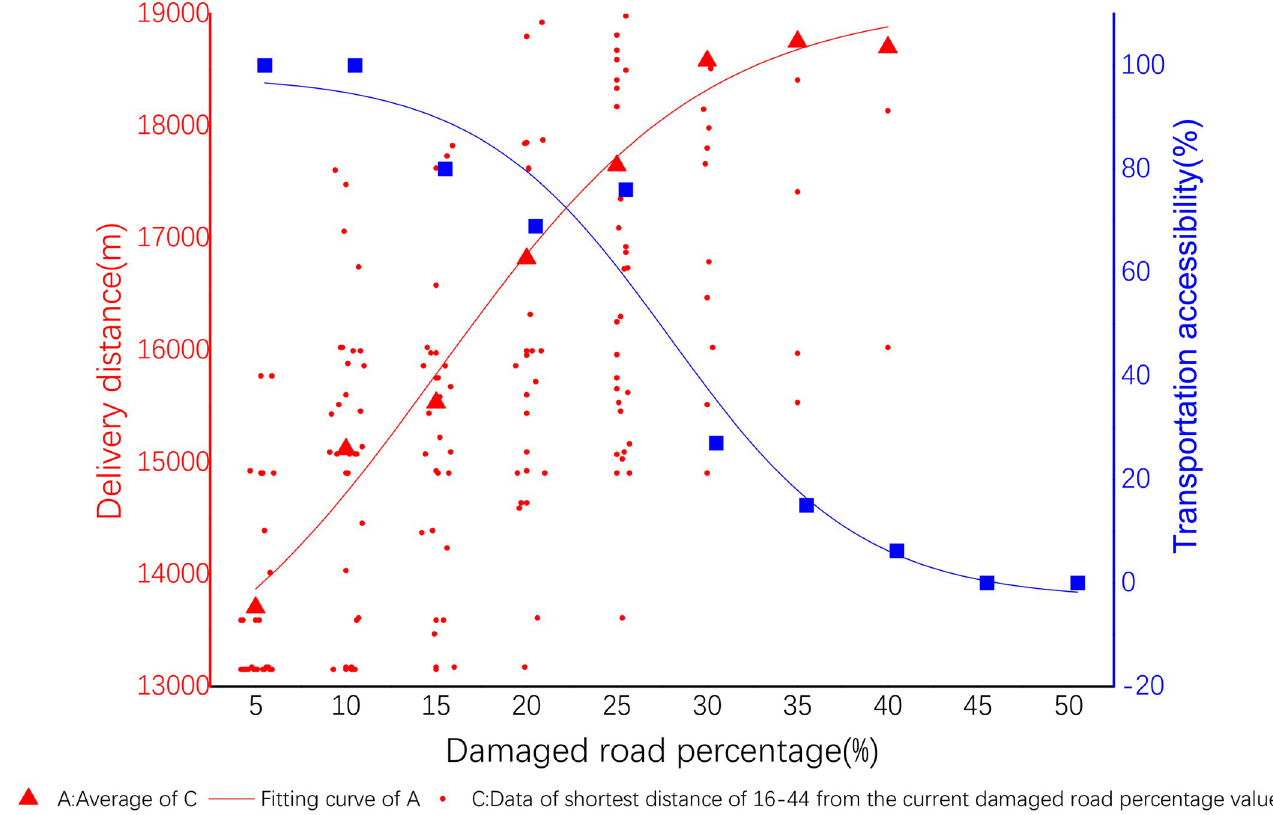
Fig 7. Delivery cost and spatial accessibility of 16–44.